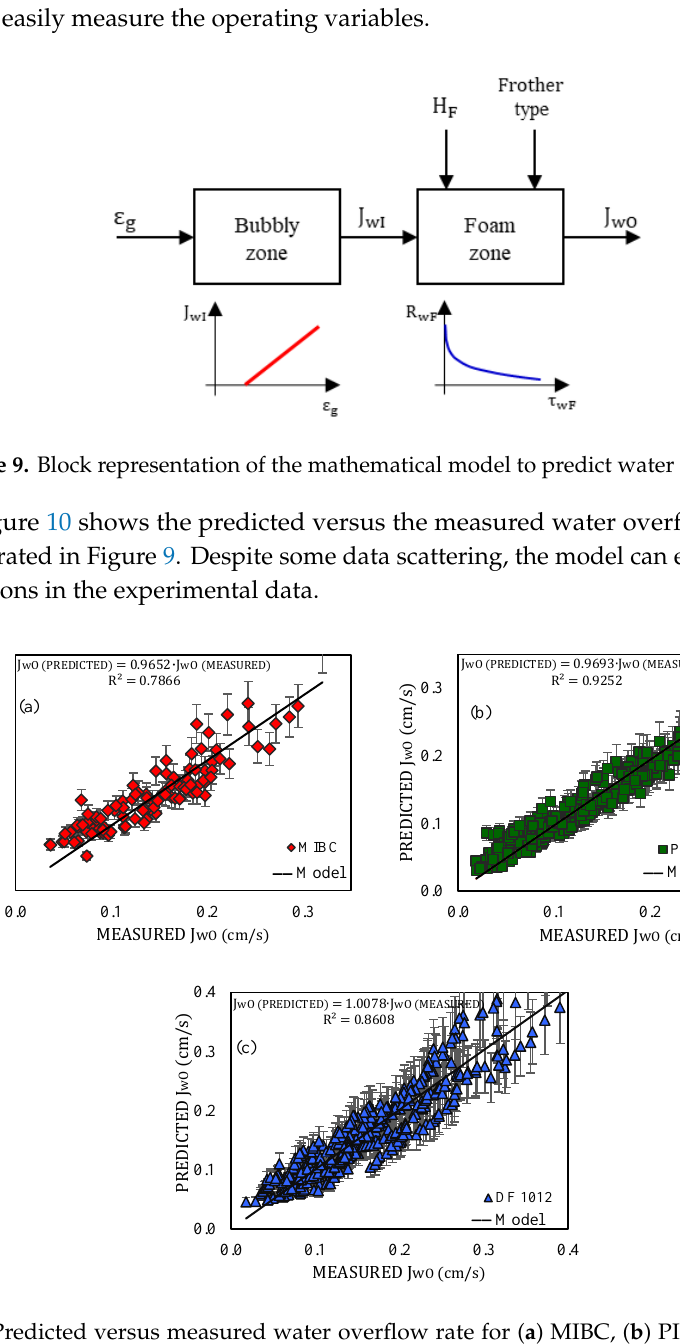
Figure 10. Predicted versus measured water overflow rate for ( a ) MIBC, ( b ) PINNACLE 9891 and ( c ) DF 1012.